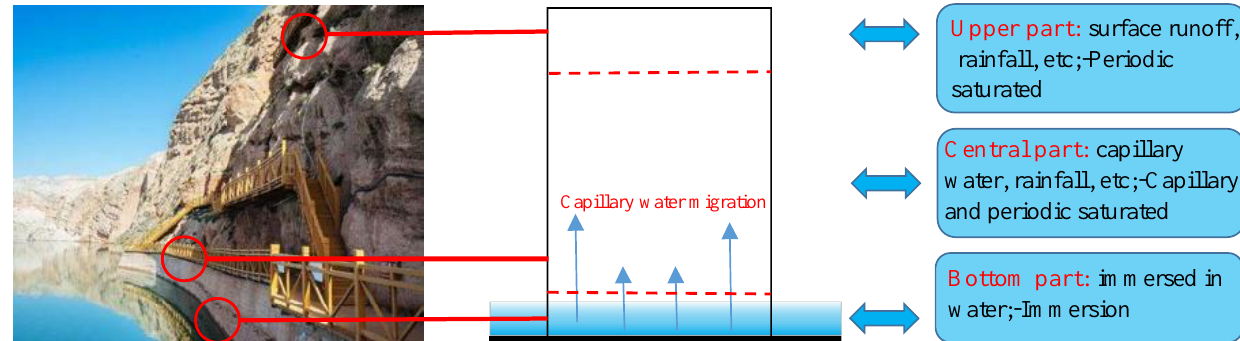
Figure 1. Schematic diagram of different parts of stone cultural relics.